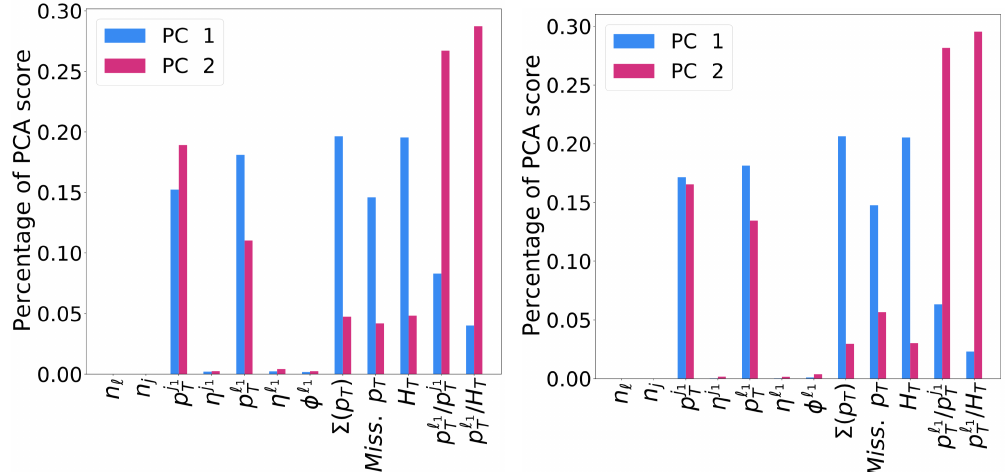
Figure 2 . PCA bar plot for the feature investigation step, including the features selected by the PCA analysis for two benchmark ( m ˜ µ , m ˜ χ ) cases: (210, 65) GeV on the left and (240, 135) GeV on the right. Similar features are identified for both